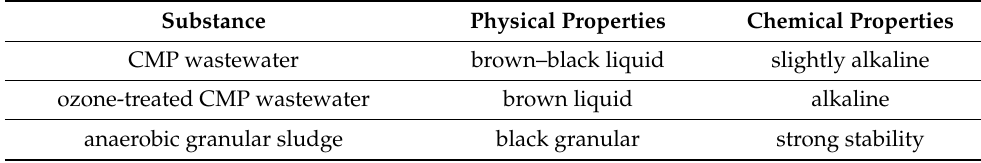
Table 1. Initial physicochemical properties of experimental